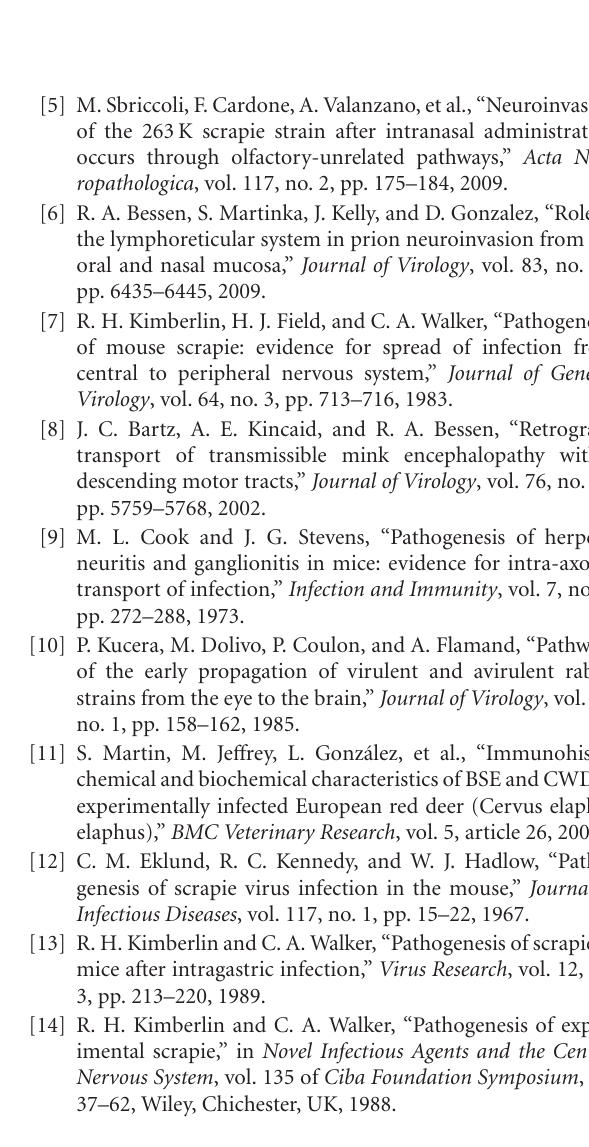
Figure 9: Schematic view of the neuroinvasion process involving the roles of the blood and the CVOs. For abbreviations see text and Figure 7